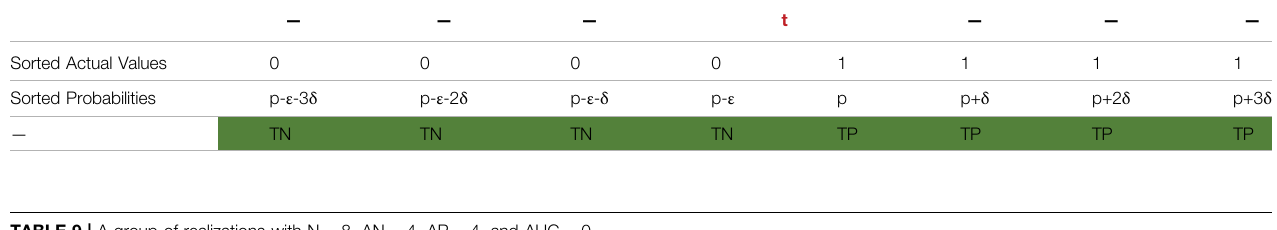
TABLE 9 | A group of realizations with N (cid:1) 8, AN (cid:1) 4, AP (cid:1) 4, and AUC (cid:1) 0. — — — t — — — Sorted actual values 1 Sorted probabilities —